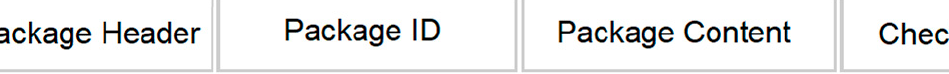
Figure 7. Communication package.